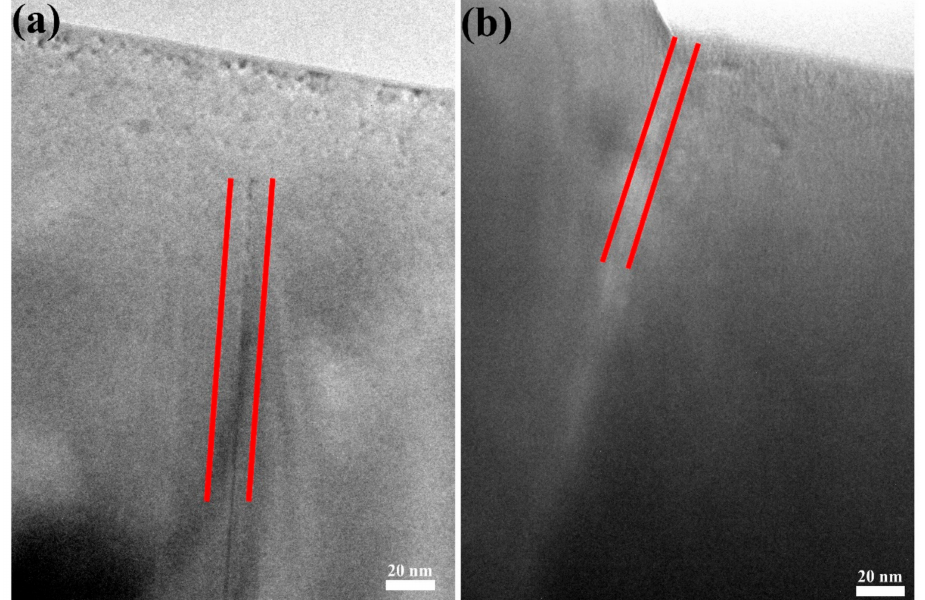
Figure 2. The cross-sectional TEM images of GaN grown by hydride vapor phase epitaxy (HVPE) with V / III ratio of 83.3 ( a ) and 27.0 ( b